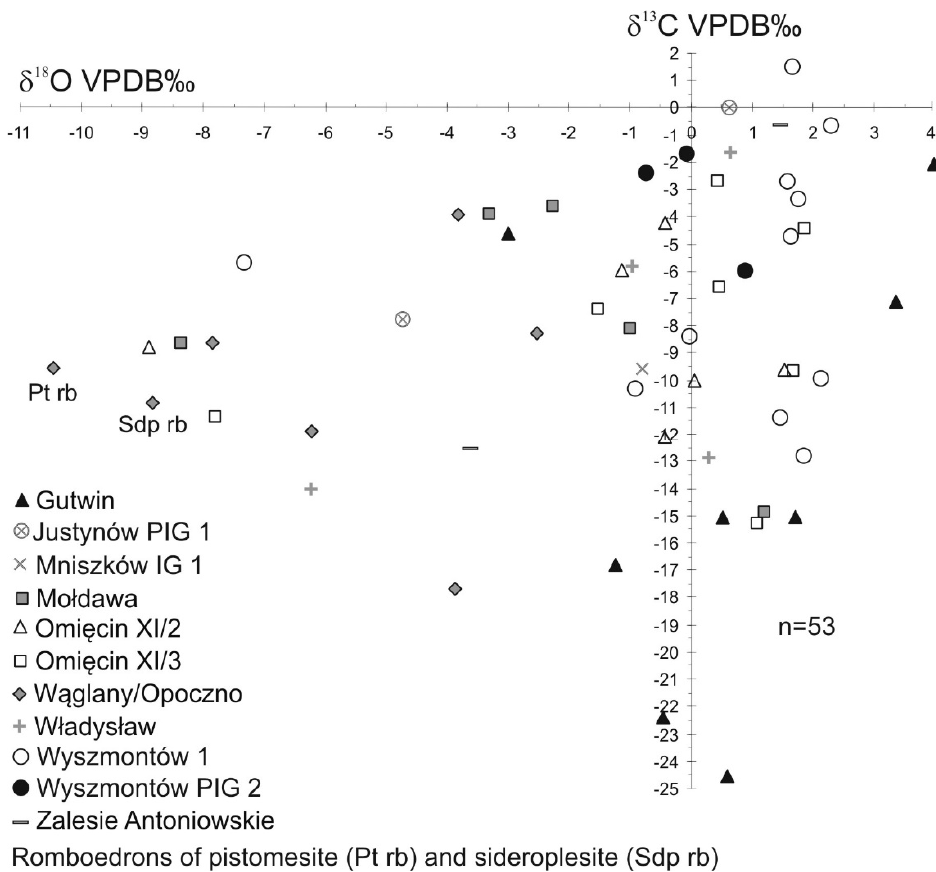
δ 13 C VPDB ‰ versus VPDB ‰ in siderite